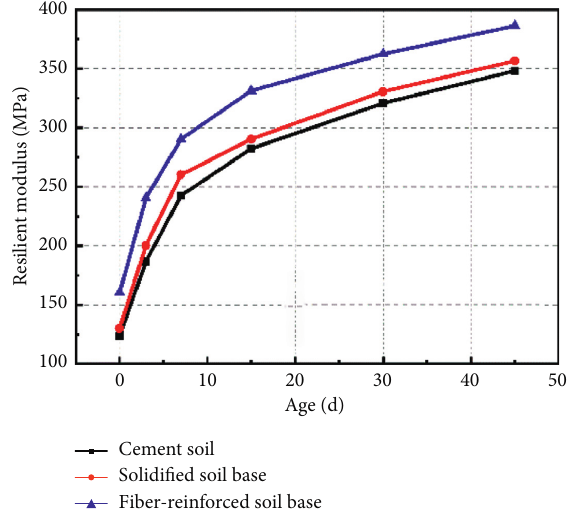
Figure 15: Variation rules of resilient modulus of base course with